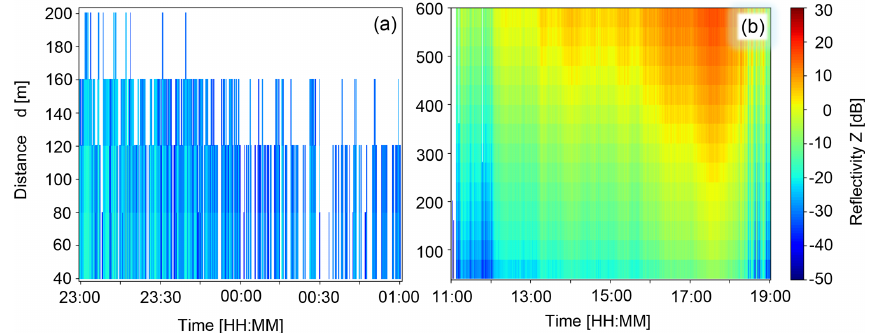
Figure 3. MRR reflectivity for (a) part of EP2 (6–7 March 2019) for pure blowing snow events and (b) EP3 (14 March 2019) for blowing snow with concurrent snow